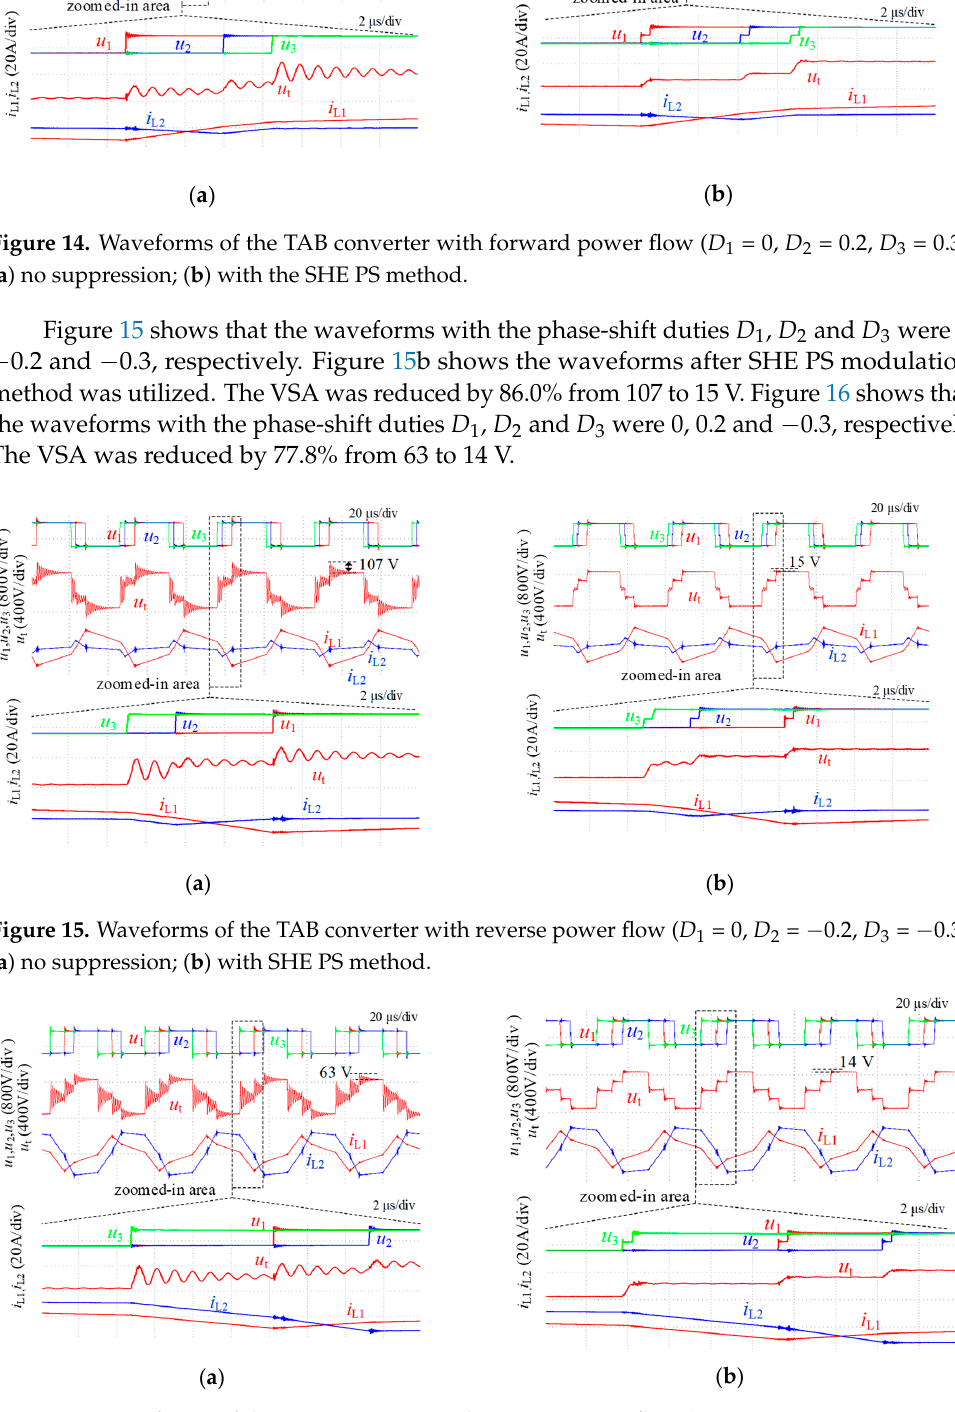
Figure 17. Harmonics spectrum of the transformer voltage in the TAB converter. The efficiency curve of the DAB prototype is shown in Figure 18, where V P1 = V P2 = 220 V. When the HFO was suppressed, the efficiencies were increased by 0.3~0.4% after the SHE PS modulation method was utilized. Figure 18. Efficiency curve of the DAB prototype. 6. Conclusions η ( % )